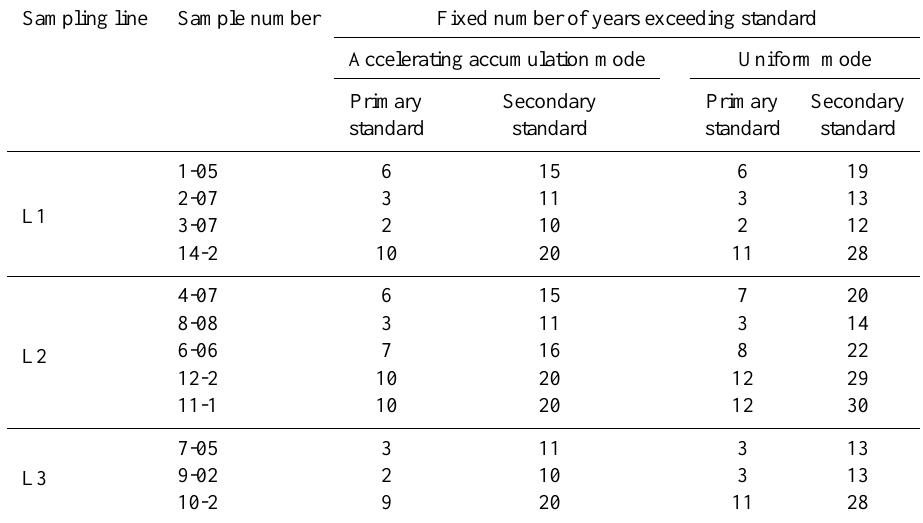
Table 5. The fixed number of years exceeding the standard of Cd in soil around the coal gangue dump (year). Sampling